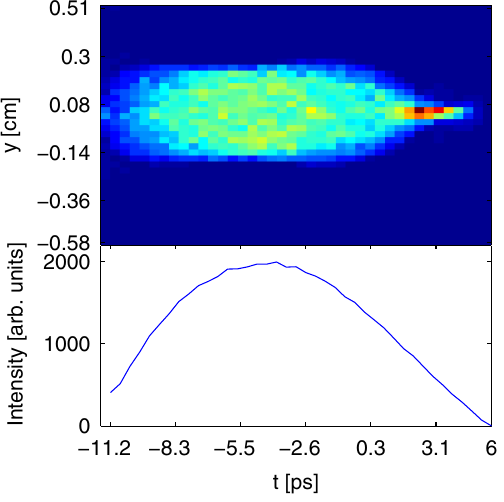
FIG. 1. PARMELA simulation of the beam as seen at the linac entrance. As can be seen the beam assumes an approximately ellipsoidal shape. The antisymmetry is due to image charge effects at the cathode. Below the configuration space plot is the temporal projection of the PARMELA -generated distribution at the linac